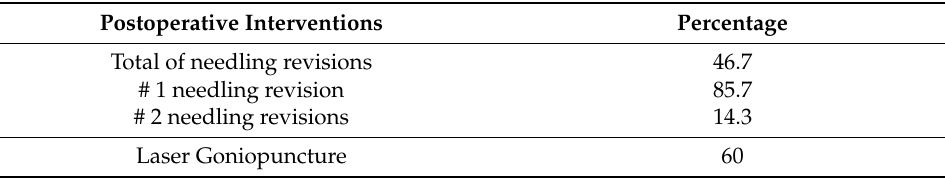
Table 3. Postoperative interventions during the follow-up.